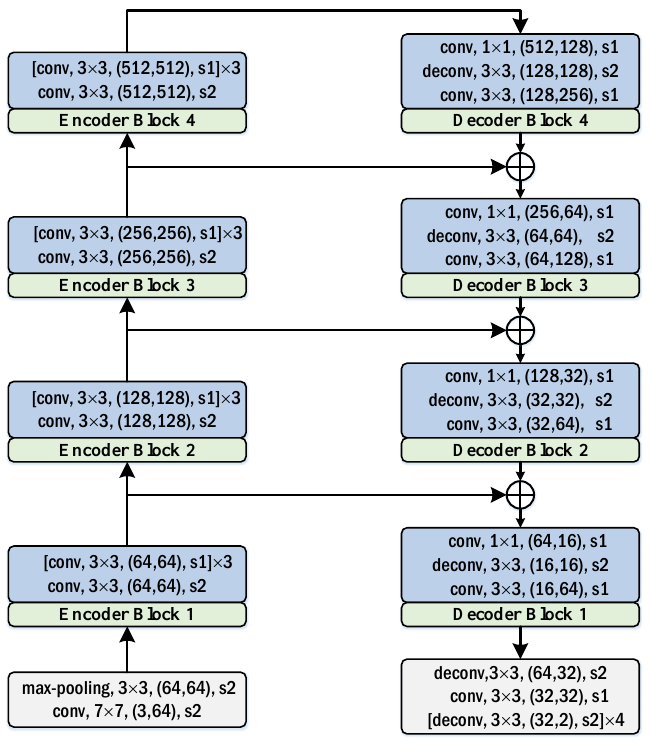
Figure 3. The encoder-decoder semantic segmentation network